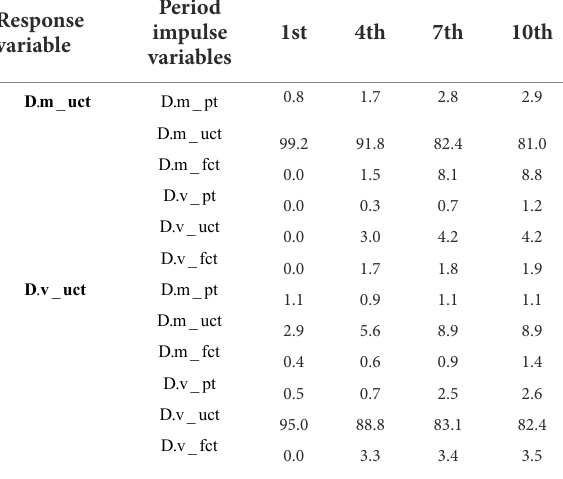
TABLE 6 The source of contribution ( . _ Dm uct or . _ Dv uct as response variable). Period Response impulse variable